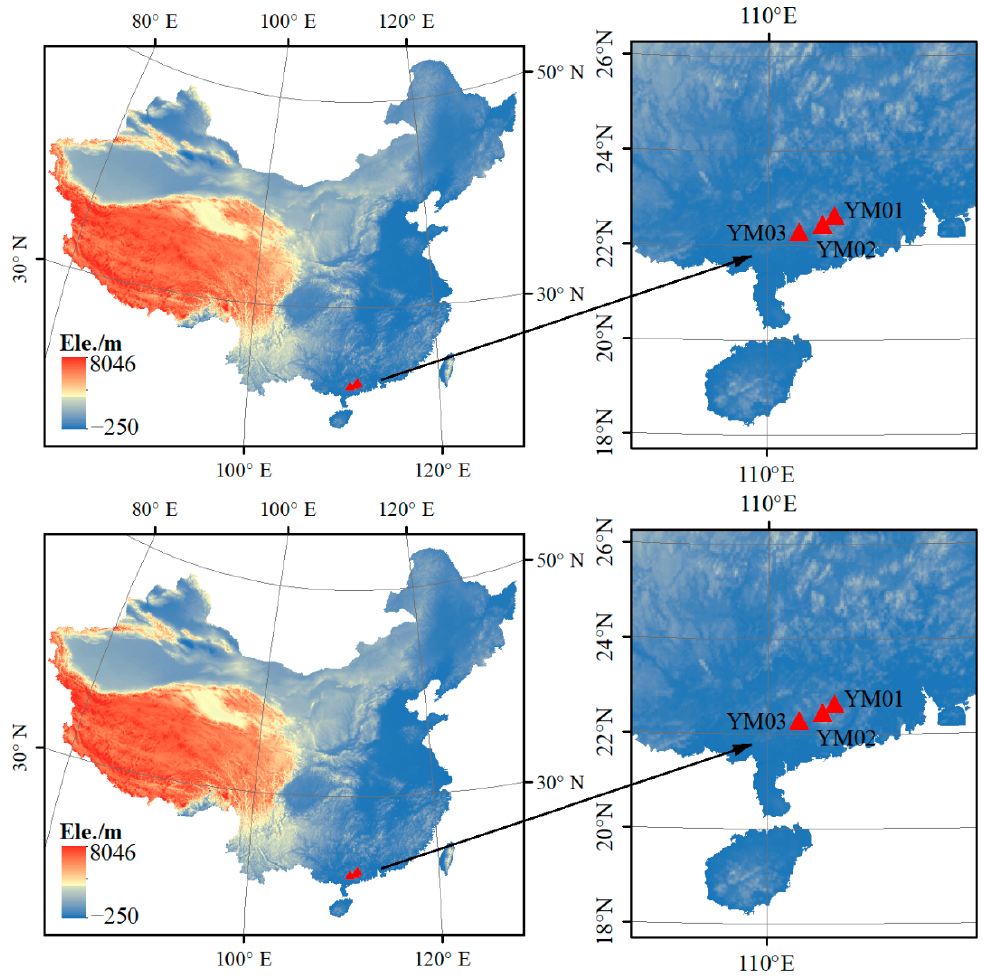
Figure 1. Geographical distribution of ground-based GNSS collocated meteorological stations in the selected area. Table 1. Geographical information of the three ground-based GNSS collocated meteorological sta- tions and statistics during the experimental data period.